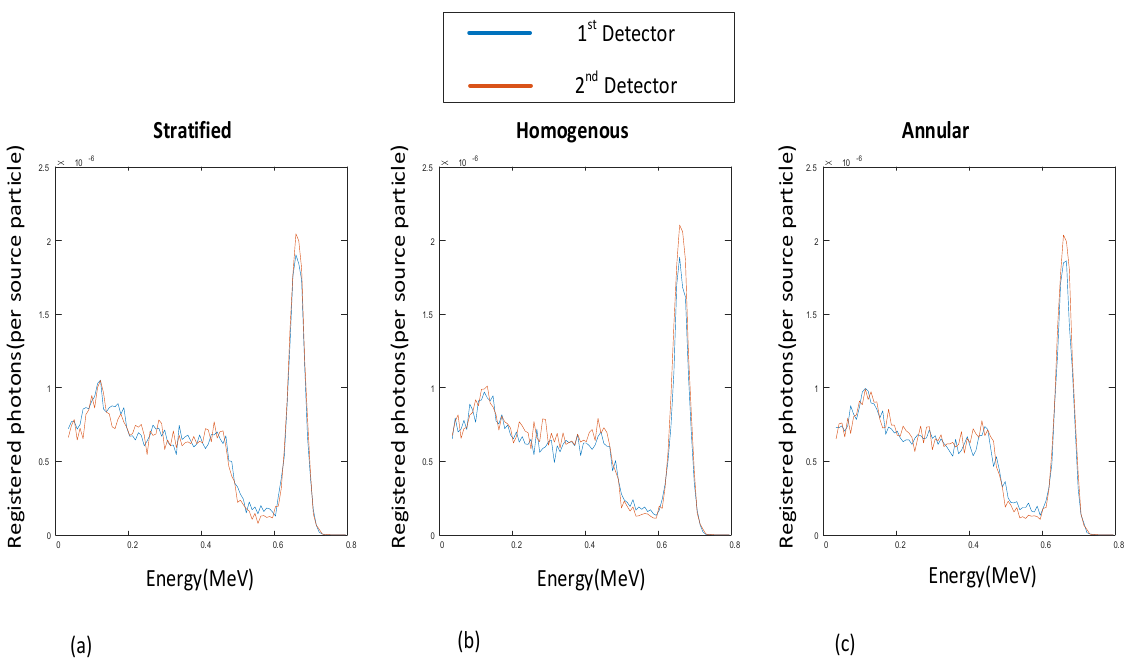
Figure 1. Registered signals in the 1st detector and 2nd detector (void fraction = 5%) for three flow regimes: ( a ) Stratified, ( b ) Homogenous, ( c ) Annular